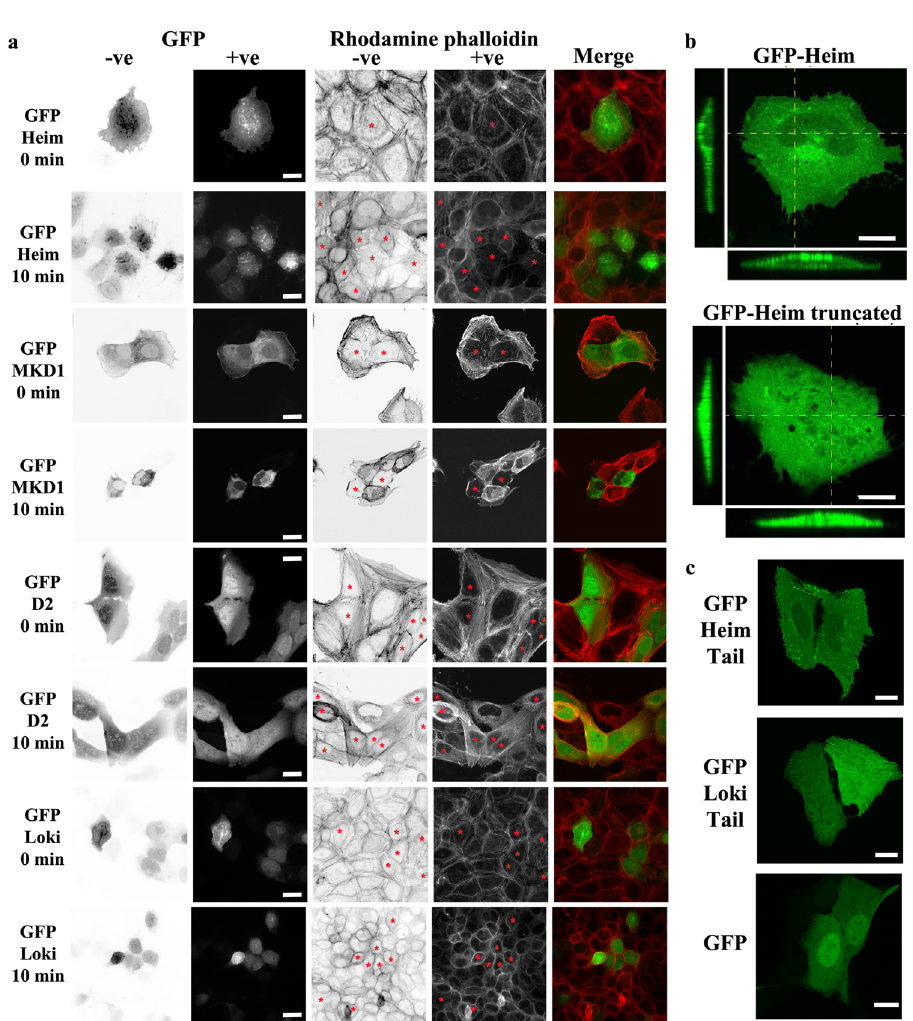
Fig. 6 Localization and activities of heterologously expressed Asgard 2DGels in mammalian cells. a U2OS cells expressing hybrid GFP constructs fused to Heim2DGel (Heim), MKD1-2DGel (MKD1), MKD1-2DGel domain 2 (D2), and Loki2DGel (Loki) were imaged before (0min) or after (10min) treatment with ionomycin to release cellular calcium stores. First two columns indicate the expression of the GFP-tagged proteins. “ + ve ” and “– ve ” indicate normal and reversed images, respectively. The subsequent two columns detect F-actin structures imaged by rhodamine phalloidin staining. Red asterisks indicate cells expressing GFP-tagged proteins. The fi nal column depicts merged images of the GFP (green) and F-actin (red) channels. Scale bars = 20 μ m. b Typical GFP- channel images of U2OS cells expressing hybrid GFP constructs fused to Heim2DGel (Heim) or Heim2DGel without the Tail (Heim truncated) indicating that the presence of the Tail preferentially excludes the protein from the nucleus. Panels to the left and below show the Z-plane. Scale bars = 10 μ m. c Typical GFP- channel images of U2OS cells expressing hybrid GFP constructs fused to the Heim2DGel Tail, Loki2DGel Tail or GFP alone. Scale bars = 20 μ